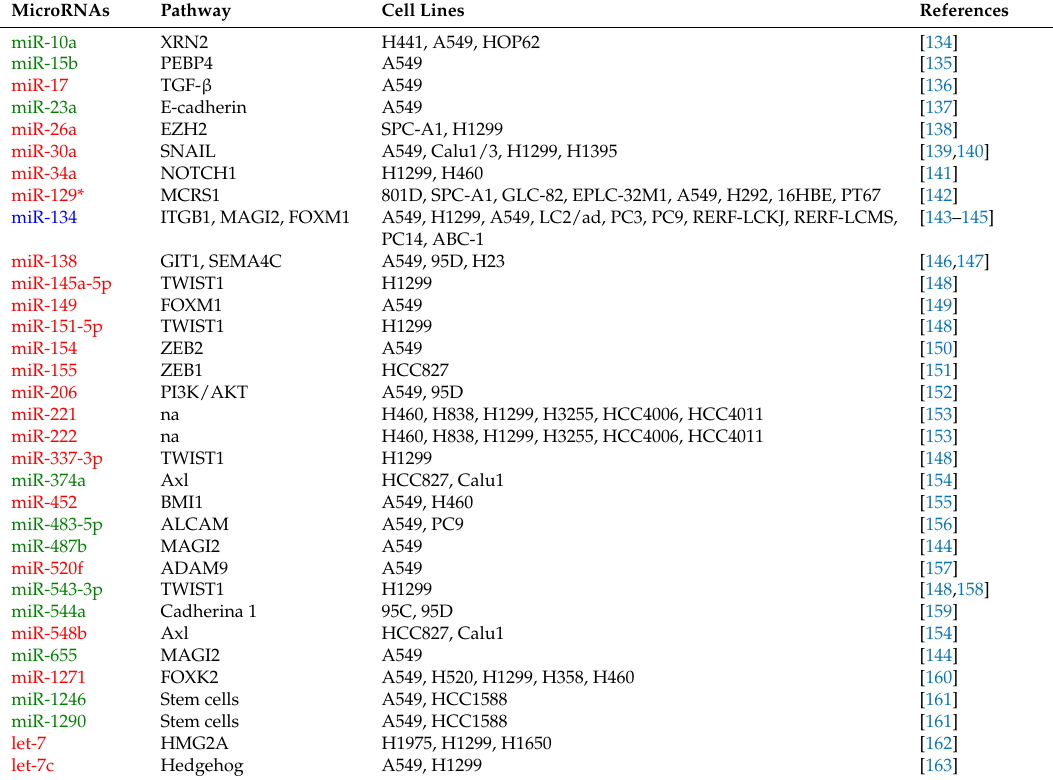
Table 1. List of EMT involved miRNAs based on NSCLC cell lines studies, with details on the involved pathways (green, promote EMT; red, suppress EMT; blue, controversial). MicroRNAs Pathway Cell